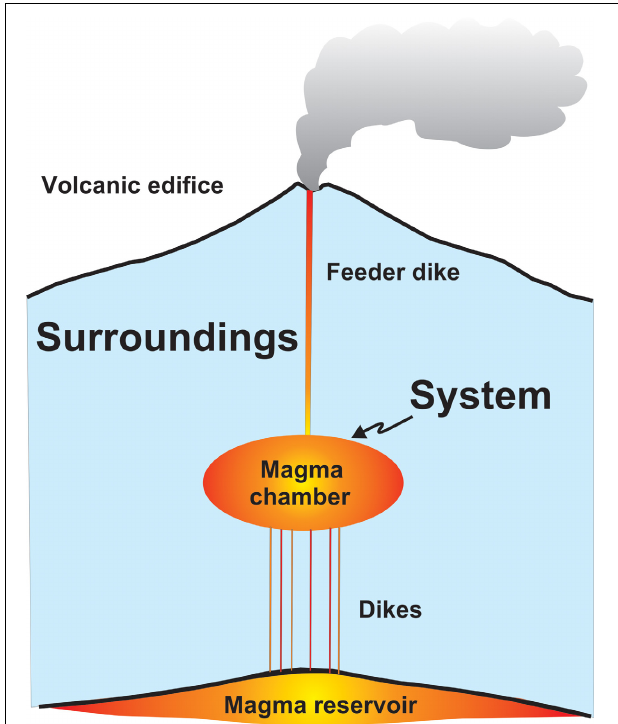
FIGURE 5 | Magma chamber as a thermodynamic system. Here the magma chamber is the thermodynamic system. The hosting crustal segment, including the volcanic edifice for which the magma chamber is a source (it supplies magma to the volcano) as well as the deeper reservoir, for which the magma chamber acts as a sink (it receives magma from the reservoir), acts as the surroundings to the magma-chamber system. In the present notation, heat received by the magma chamber and work done on the magma chamber (by the surroundings) are regarded as positive.